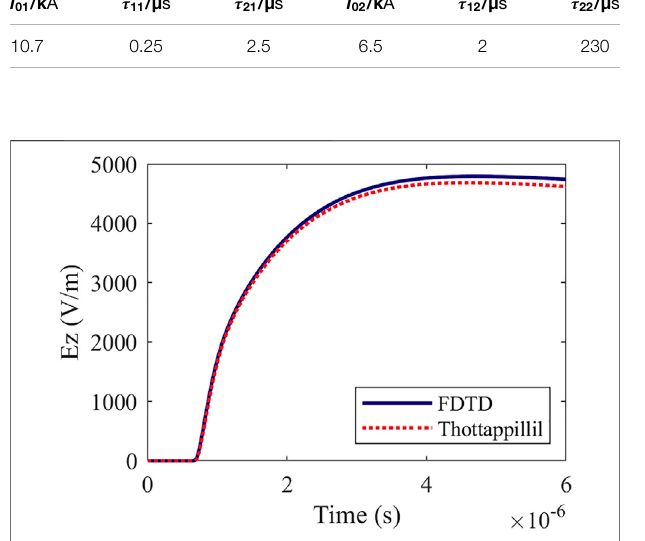
FIGURE2| ExaminationoftheFDTDmodelbycomparingittotheresult of Thottappillil formula.